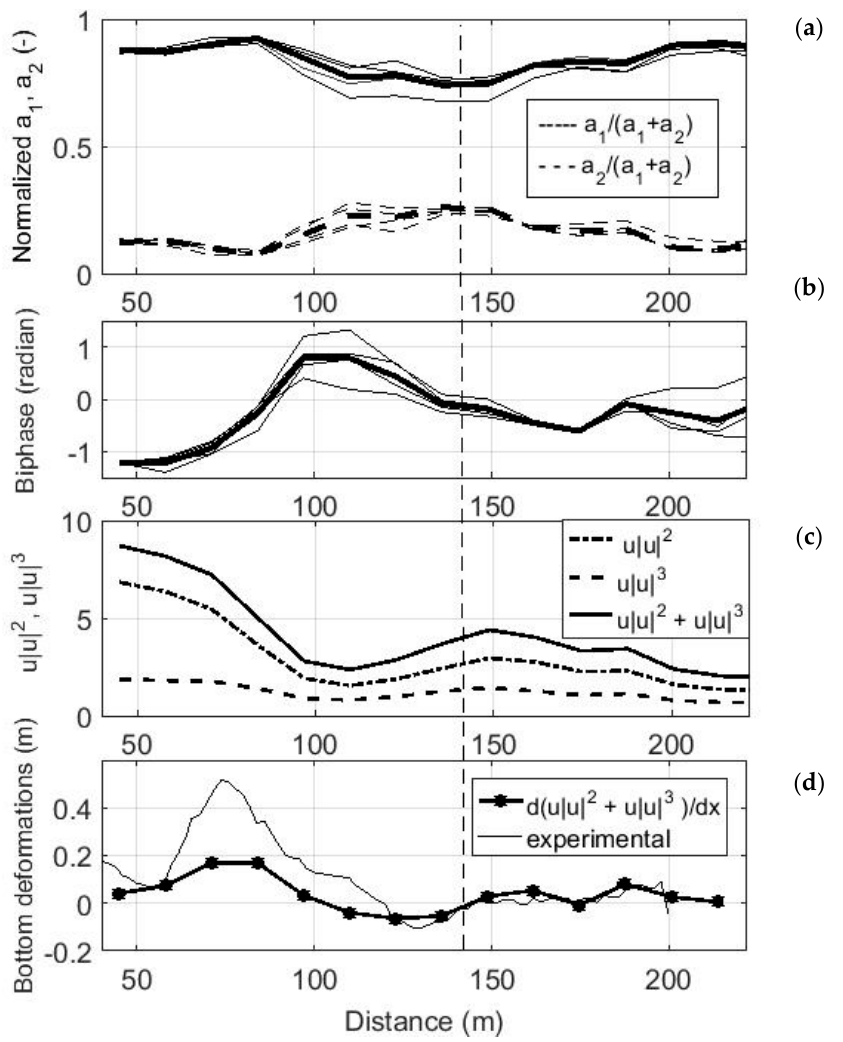
Figure 5. The evolution of normalized amplitudes of first and second non-linear harmonics ( a ), biphase ( b ); the third and fourth moments of the orbital near-bottom velocity ( c ), calculated with the use of Formulas (3) and (4) for the wave situation on 28 September (series 34–39). Calculated deformations of the bottom relief and moving averaged difference in measured profiles between 28 and 29 September ( d ). The bold line shows the averaged values (series 34–39) that the calculations of velocity moments and deformations are based on.